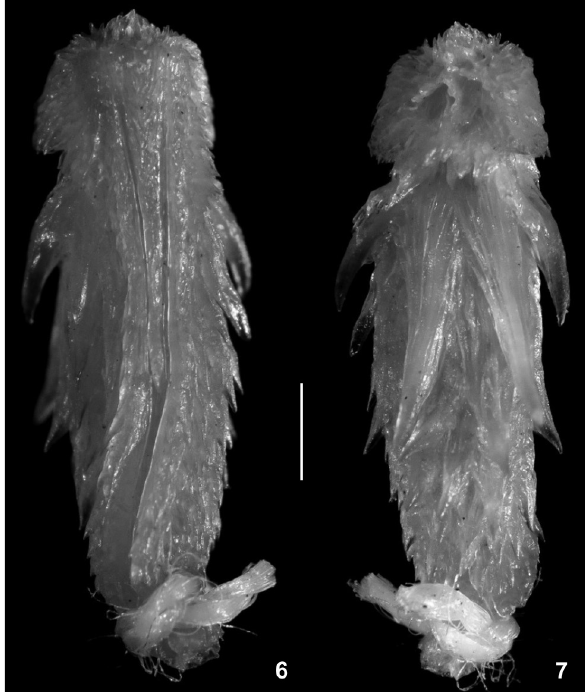
Figures 6–7. Hemipenis of Apostolepis kikoi sp. nov. (MCP 14524) from the reservoir of Manso hydroelectrical power plant, Chapada dos Guimarães, Mato Grosso, Brazil, showing sulcate (6) and absulcate (7) sides (photo by Fernanda Martins dos Santos). Scale bar: 1 mm.